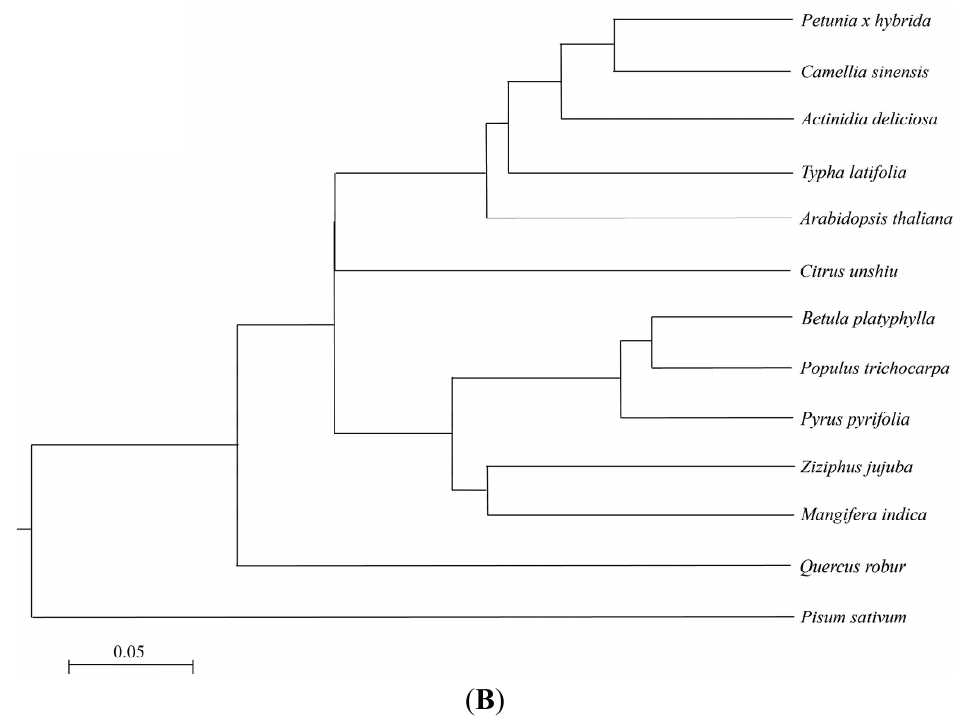
Figure 1. Multiple alignment of ZjMT and phylogenetic analysis. ( A ) Multiple alignments of MT proteins from selected species. Identical amino acid residues are highlighted in gray; ( B ) Phylogenetic analysis of MT domains from different species. All of the proteins